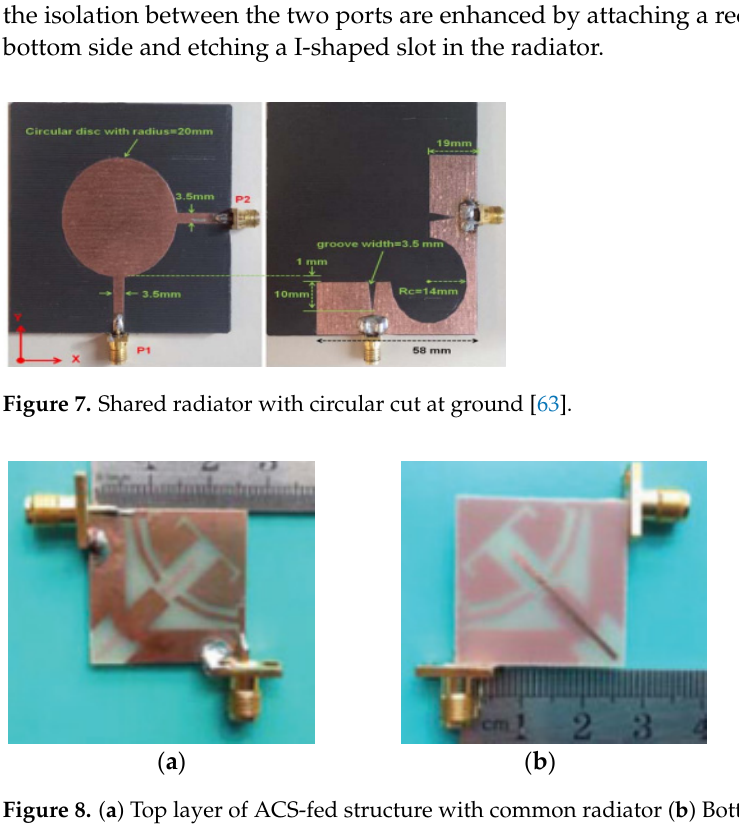
( b ) Figure 6. ( a ) Fabricated prototype with CPSE [61] ( b ) CPW-fed fabricated prototype with CPSE [62].